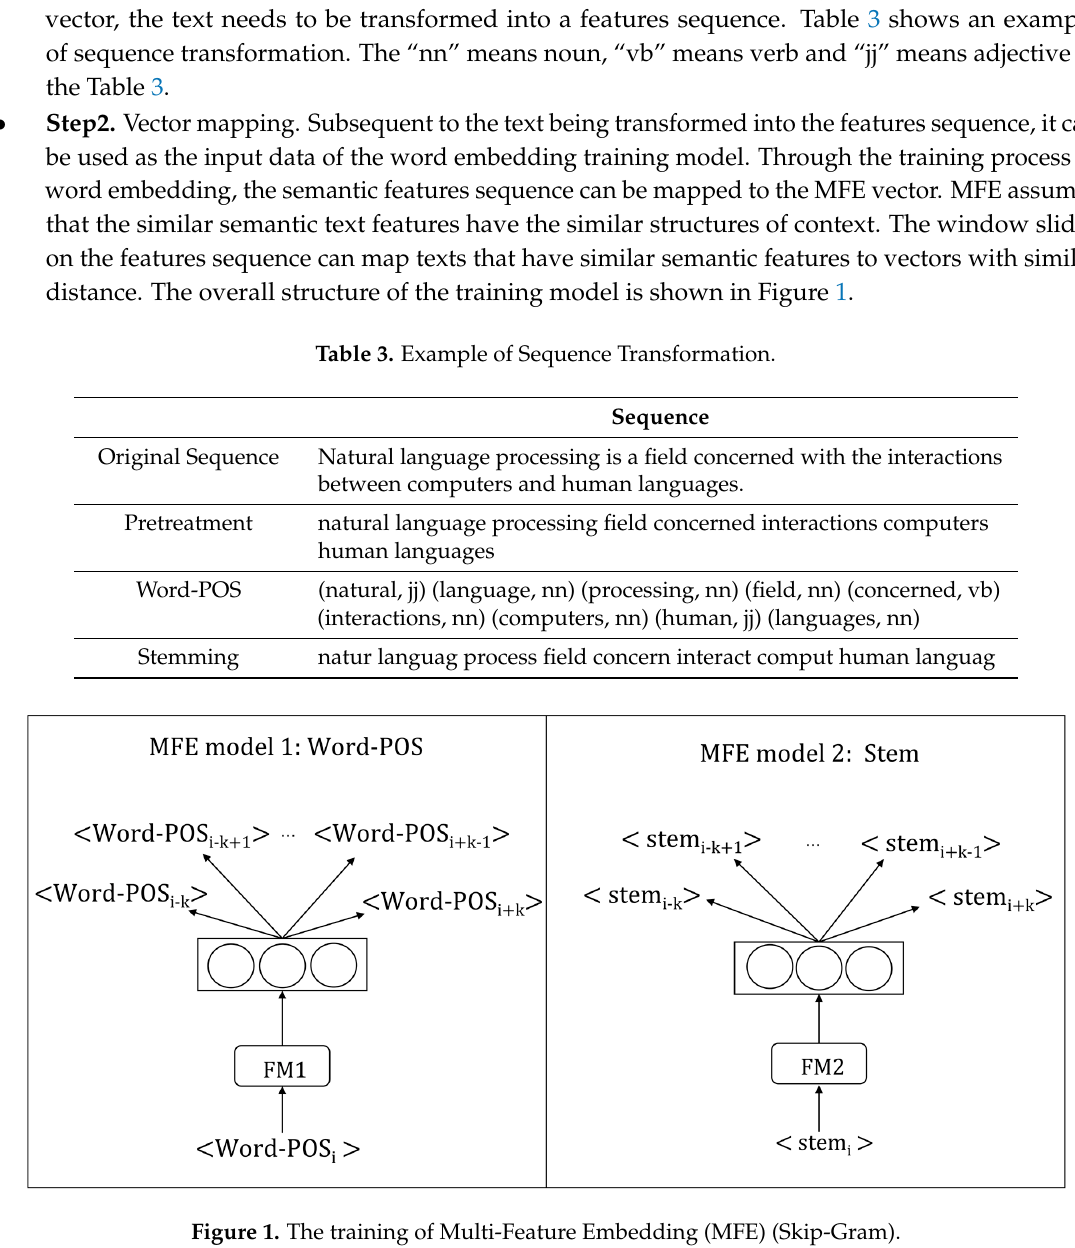
Figure 1. The training of Multi-Feature Embedding (MFE) (Skip-Gram).